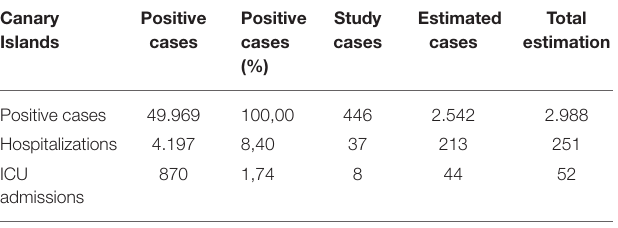
TABLE 4 | Estimated number of hospitalizations and ICU admissions. Canary Islands